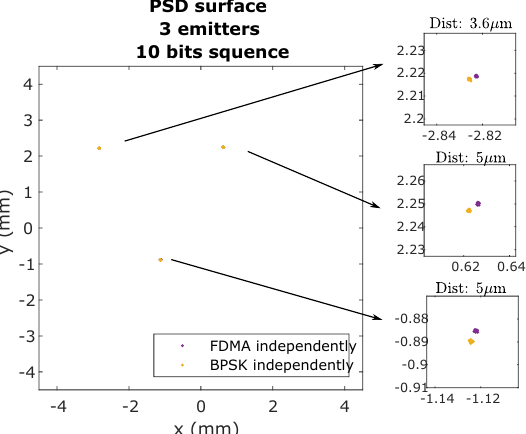
Figure 21. Impact points on the PSD surface using FDMA and using independently emitted BPSK